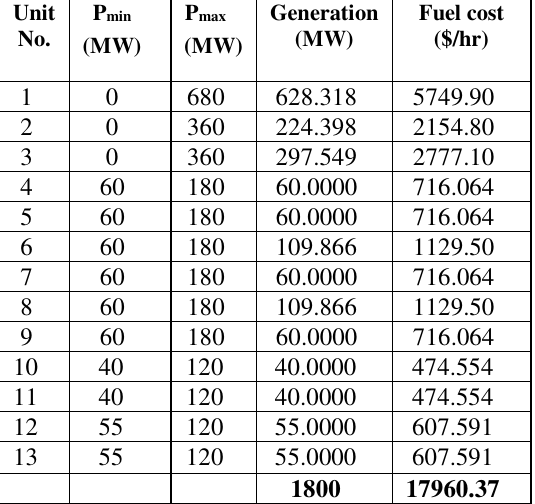
TABLE A2: OPTIMAL GENERATIONS FOR TEST CASE 3